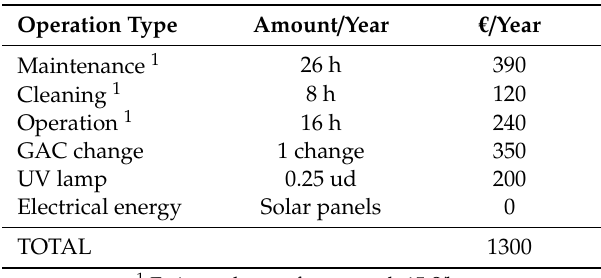
Table 7. Annual operation and maintenance cost of the